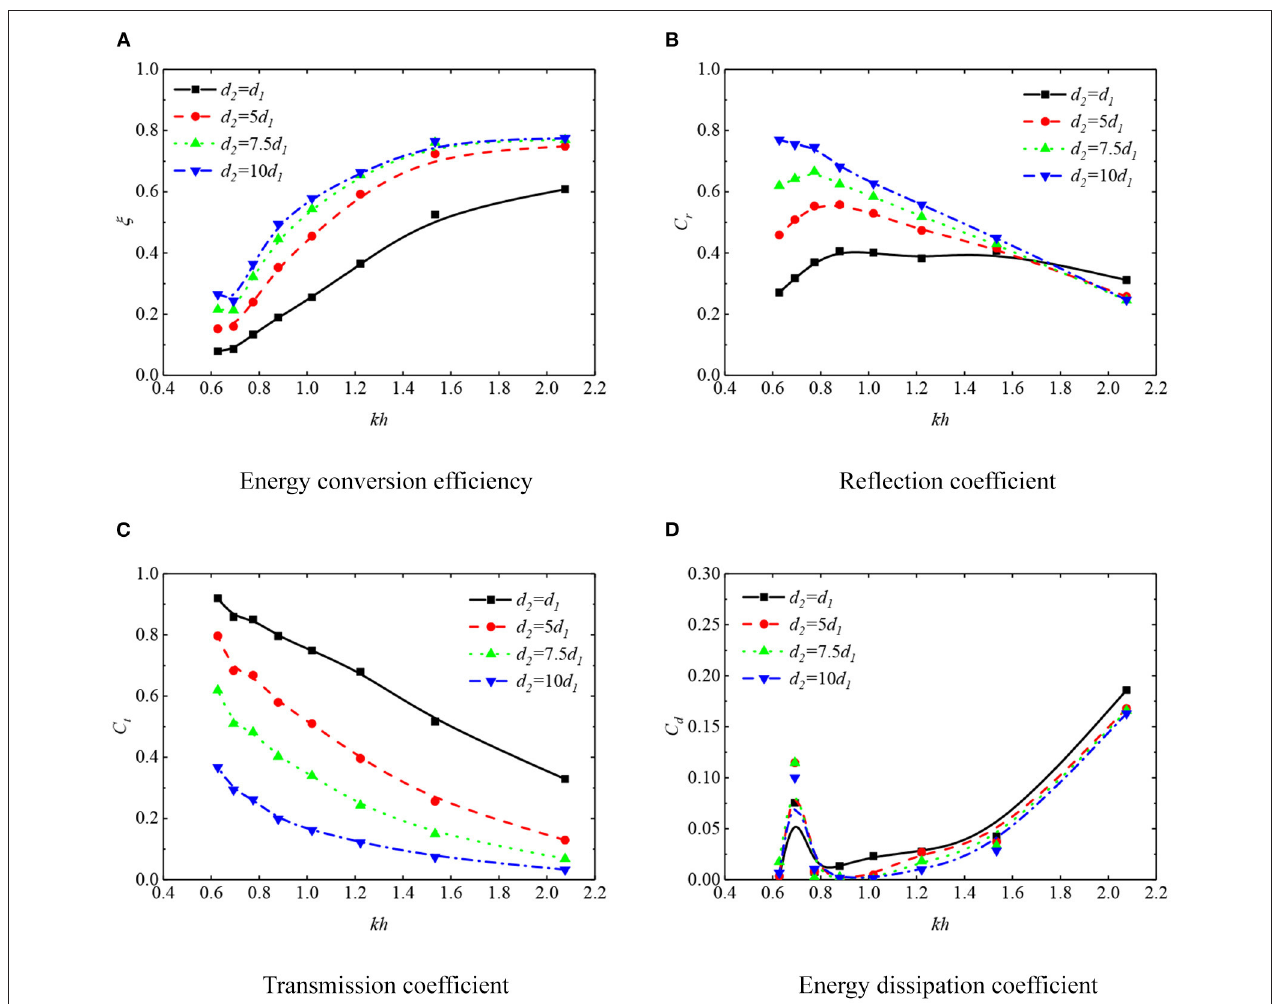
FIGURE 8 | Hydrodynamic coefficients of oscillating water column (OWC) devices with four drafts of the rear box in regular waves of H i = 0.05 m. (A) Energy conversion efficiency. (B) Reflection coefficient. (C) Transmission coefficient. (D) Energy dissipation